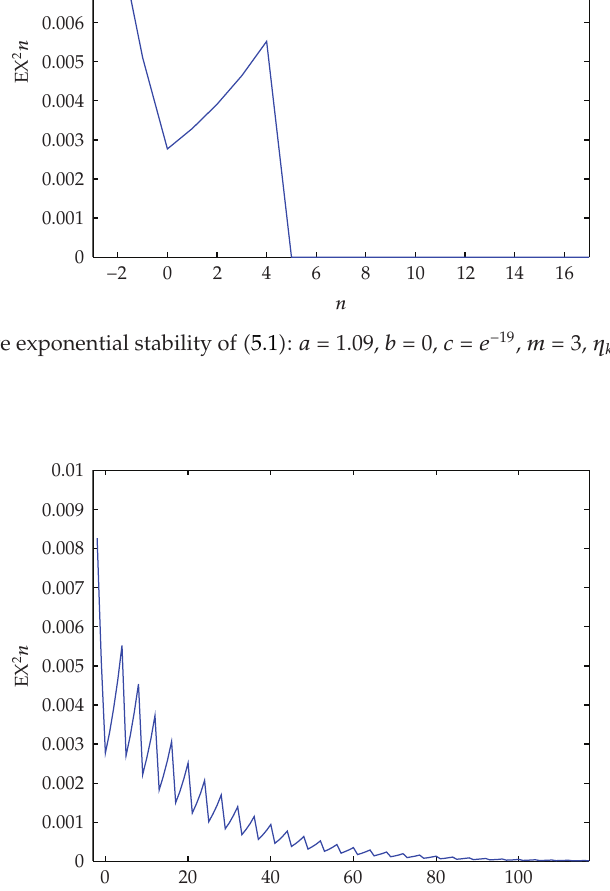
Figure 4: Stability of (cid:3) 5.1 (cid:4) : a (cid:7) 1 . 09, b (cid:7) 0, c (cid:7) e − 19 , m (cid:7) 3, η k (cid:7) 4 k , and β